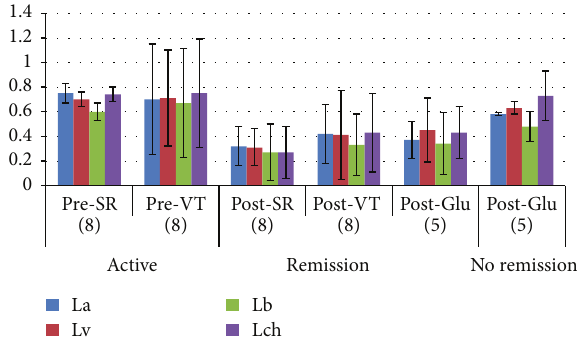
Figure 2: ELISA obtained with monovalent amastigotes and sera from patients with primary infection, with active lesions or remis- sion after SR, VT or Glu treatments. (Patients).La: L(L)amazonensis ; Lv: L(L)venezuelensis, ; Lb: L(V)brasiliensis ; Lch: L(L)chagasi. No significant correlation was found between IDR and ELISA values in 32 patients with CL. Thecorrelation indexes were forLa: 0.0098 ( 𝑃 = 0.588 ); Lv: 0.0057 ( 𝑃 = 0.88 ); Lb: 0.012 ( 𝑃 = 0.535 ); Lch: 0.026 ( 𝑃 = 0.372